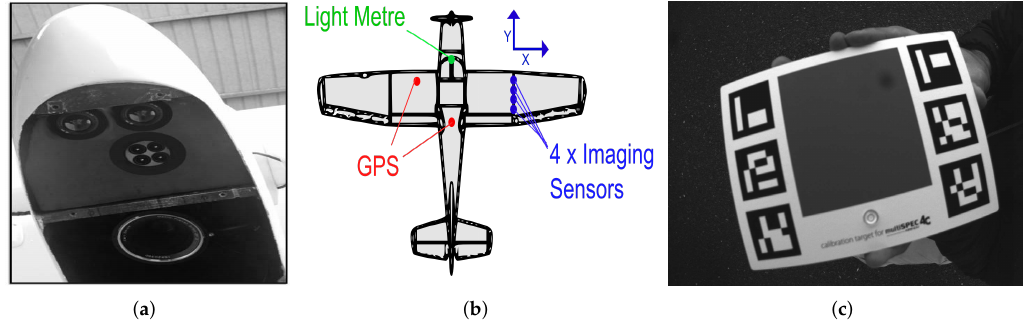
Figure 4. Sensor position and calibration on the aircraft ( a ) internal view of four sensors installed in the sensor pod—RGB at the rear and multispectral, thermal and hyperspectral mounted at the front of the pod; ( b ) all sensors are orientated in the same vehicle coordinate system and the light metre and GNSS receivers control changes in position and illumination conditions; ( c ) sensors are calibrated prior to take-off using targets of known